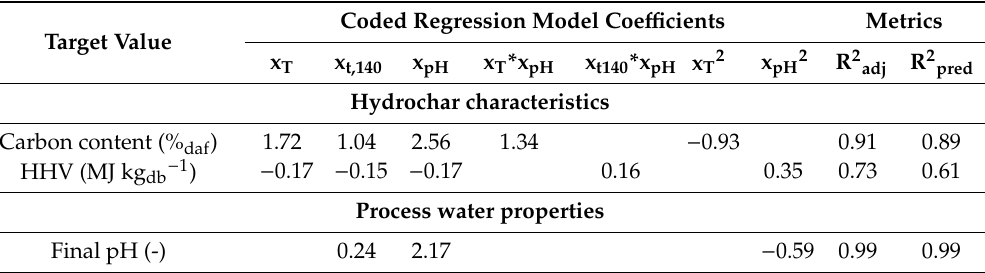
Table 3. Coded regression model coe ffi cients for hydrochar (HC) and process water properties with t 140 reaction time instead of holding time.